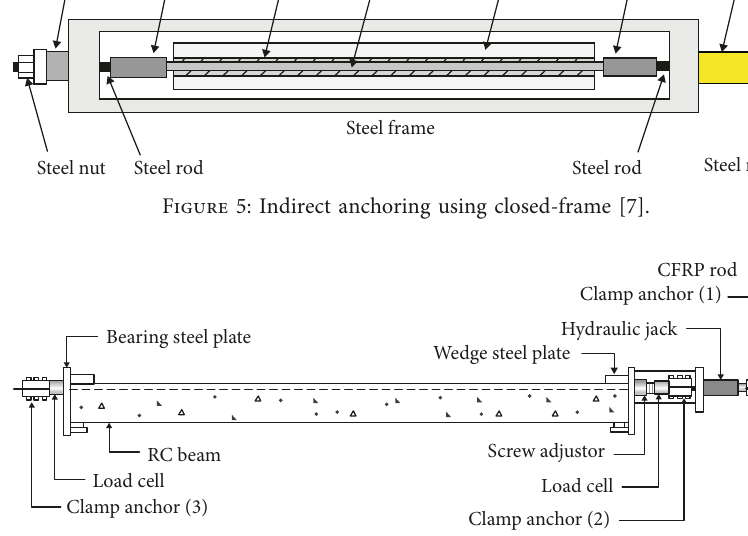
Figure 6: Anchoring by direct method